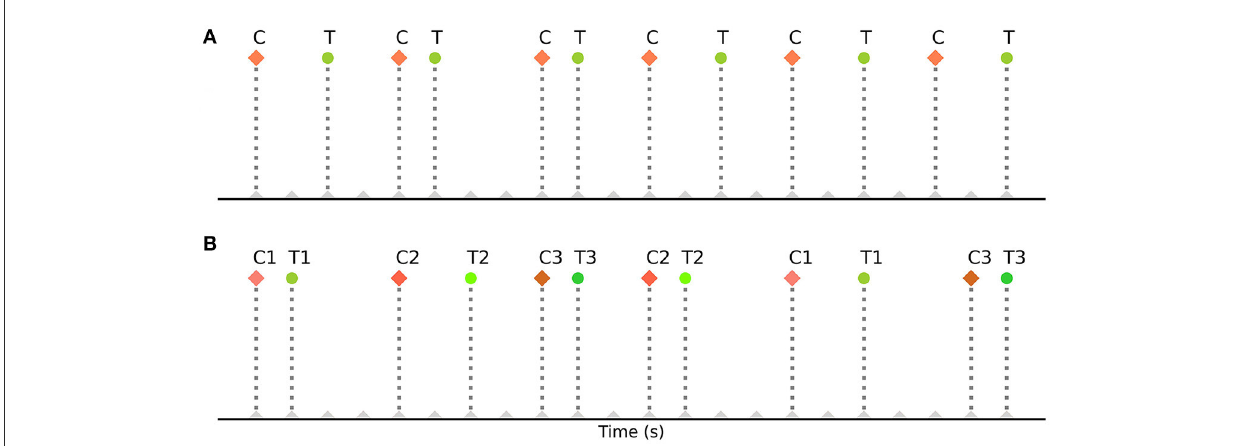
FIGURE1 Schematic representation of the entire simulation framework. Divided into two distinct pipelines, the (A) portion of the figure represents the noise pipeline, and the (B) shows the response signal pipeline. Finally, they are added together to obtain the final simulated signal for a specific set of